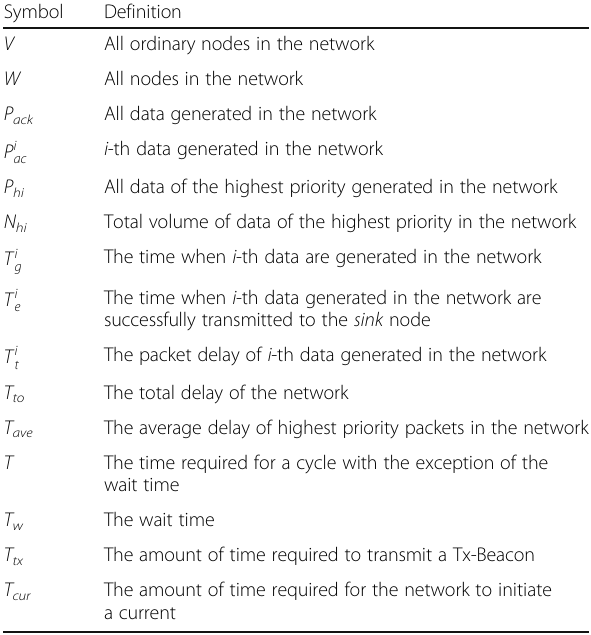
Table 1 Symbols used in this paper and their